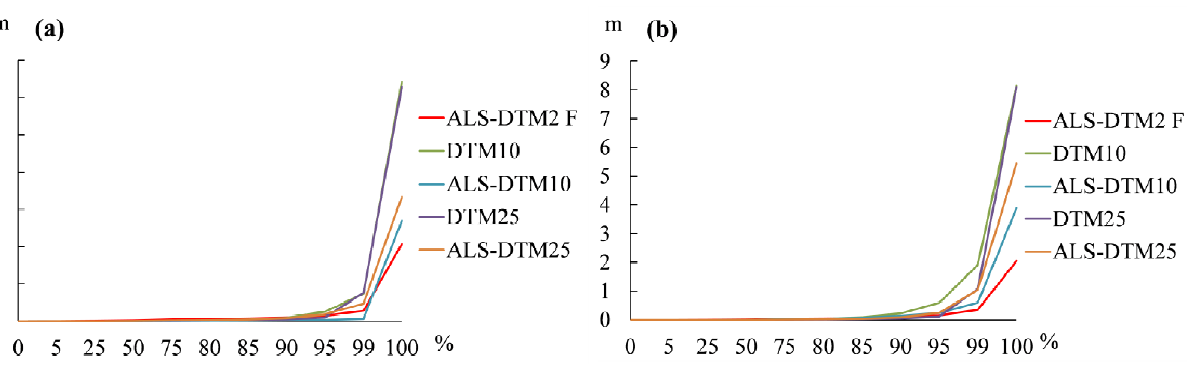
Figure 6. The distributions of depth error in ( a ) Kainastonjoki and ( b ) Nenättömänluoma River SBAs. In ALS-DTMs, the surge of depth error occurred at higher percentage points than in NLS grid